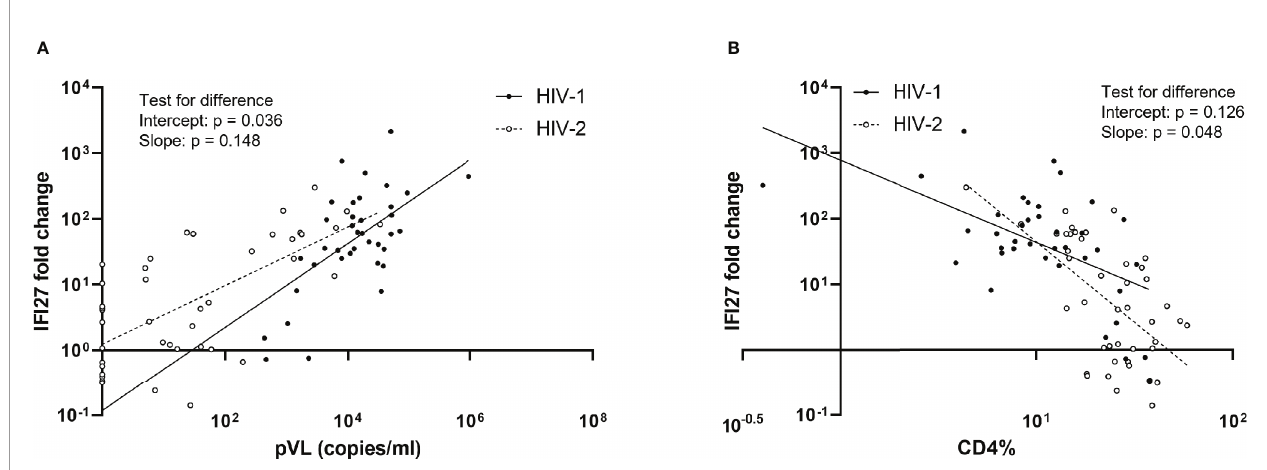
FIGURE 2 | Associations between IFI27 expression and plasma viral load (pVL) (A) and CD4% (B) . The relative IFI27 fold change gene expression, compared to HIV seronegative controls, was quanti fi ed and calculated by qPCR and the 2^- DD CT method. IFI27 fold change, pVL and CD4% were log10-transformed prior to analysis. P-values for difference between HIV-1 (n = 39 for pVL and 38 for CD4%) and HIV-2 (n = 43 for both pVL and CD4%) in intercept and slope (i.e. the interaction between IFI27 and pVL or CD4%) were calculated by crude multiple linear regression analysis, without adjustment for sex and age. Additional results from these analyses are provided in Table S3 .